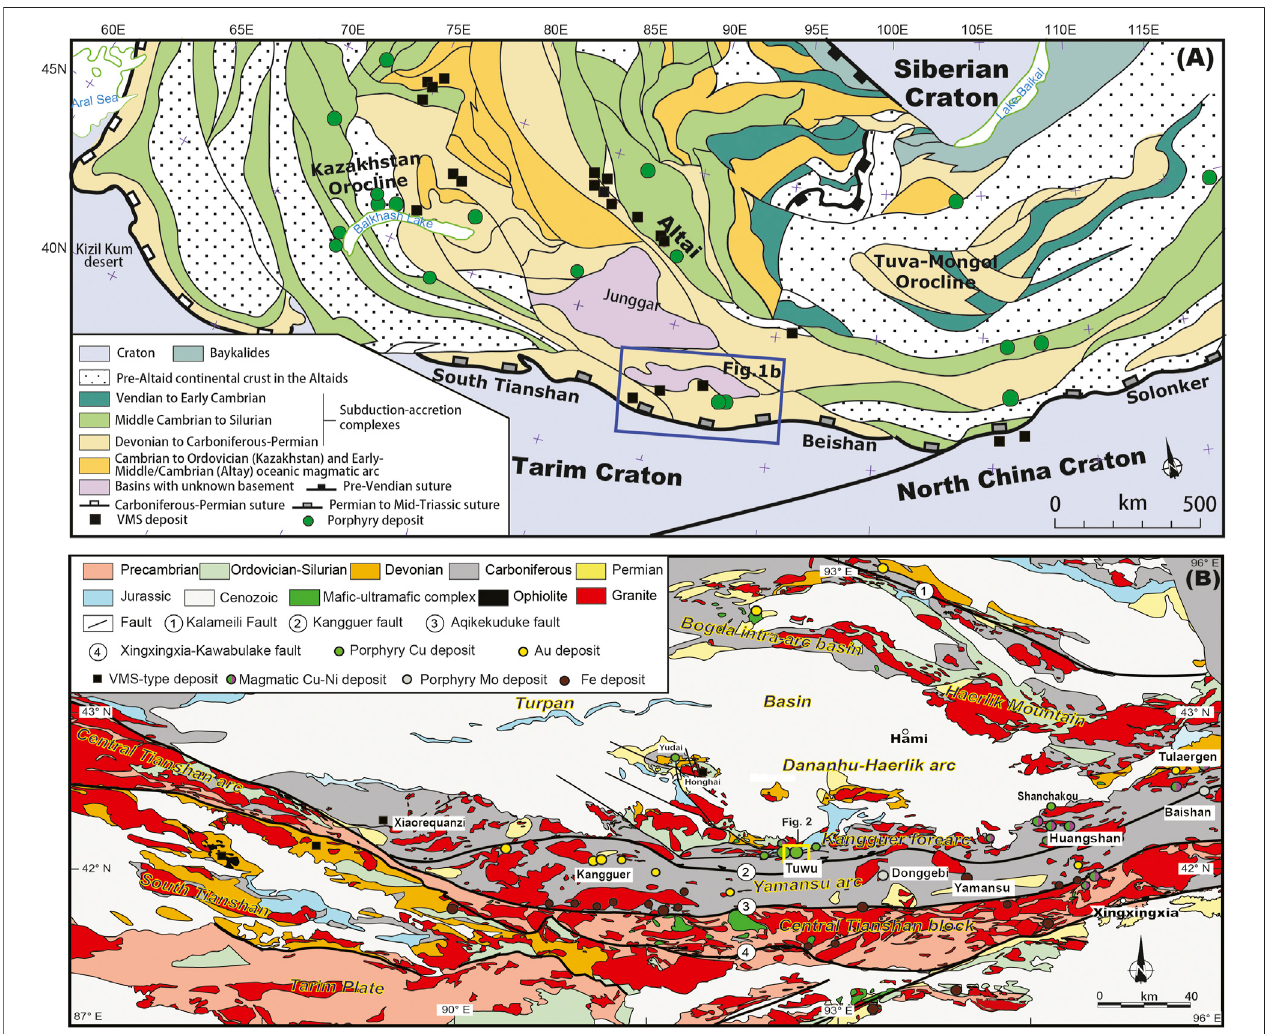
FIGURE 1 | (A) Schematic tectonic map of Central Asia (S¸ engör et al., 1993; Xiao et al., 2015) showing the position of the eastern Tianshan. (B) Schematic geological map of the eastern Tianshan [modi fi ed after Mao et al. (2017) and Xiao et al. (2004)] showing the location of the Tuwu area. The major faults separating the southern Tianshan, Central Tianshan arc, Yamansu arc, and Dananhu-Haerlik